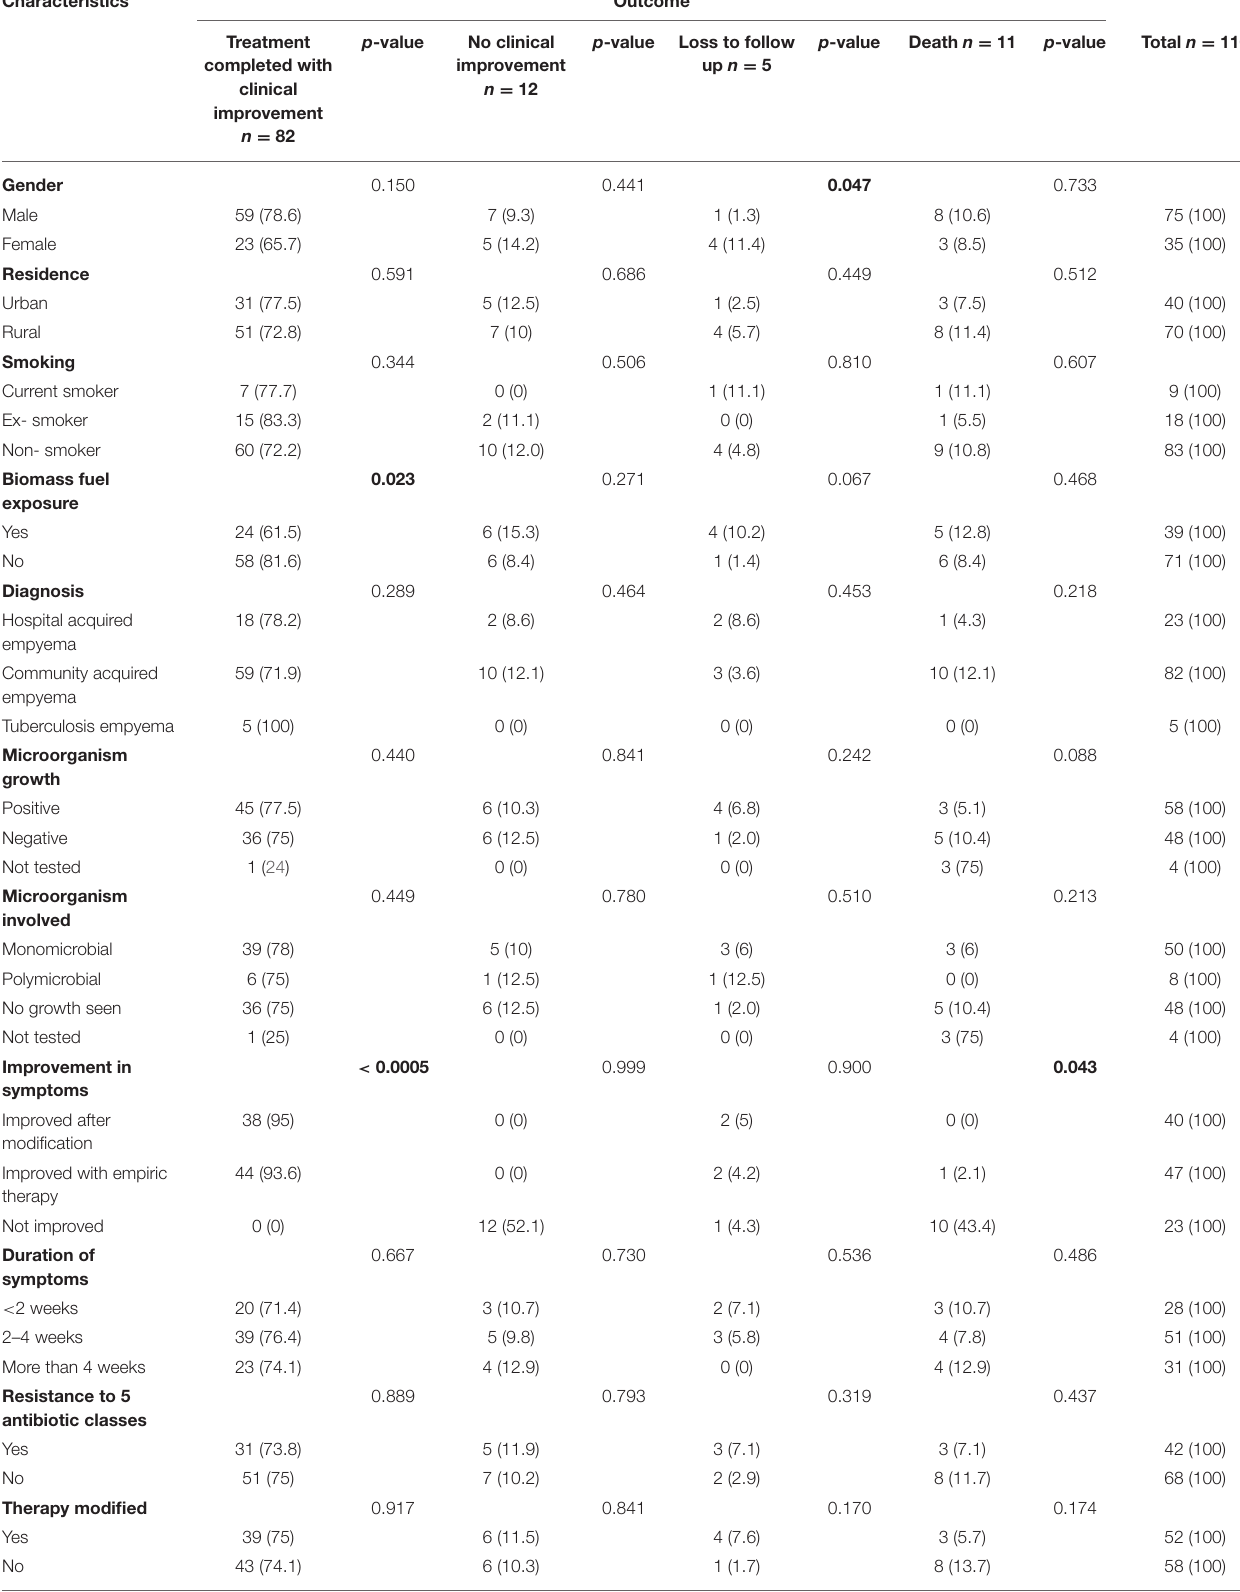
TABLE 6 | Treatment outcomes with regard to patient characteristics.